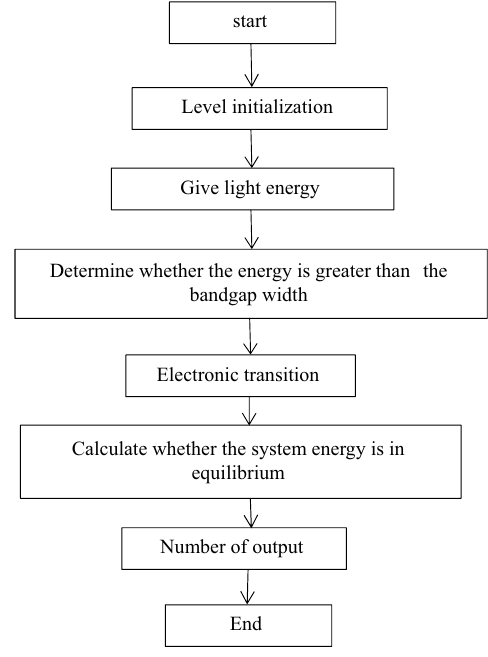
Figure 1: Flowchart of calculation